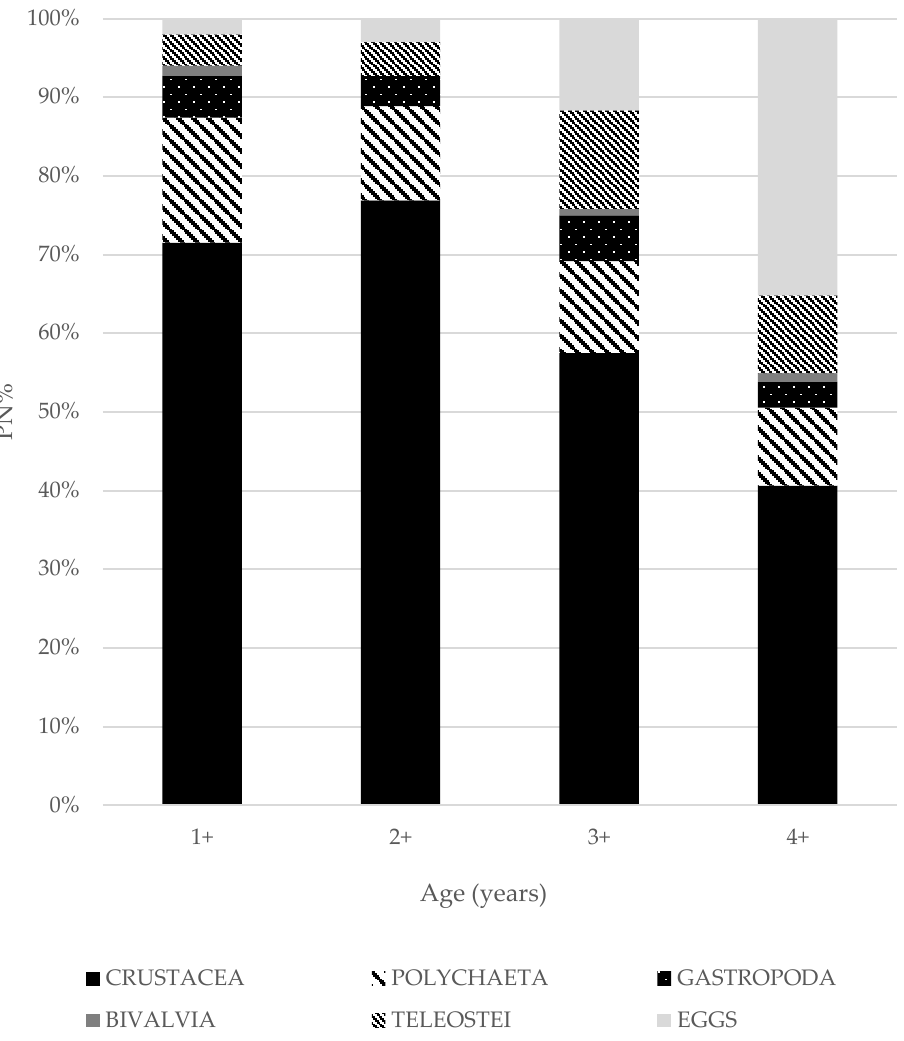
Figure 2. Comparison of prey proportions (%PN) in S. scriba diet . Table 7. Trophic level (TROPH) of different age groups of S. scriba.